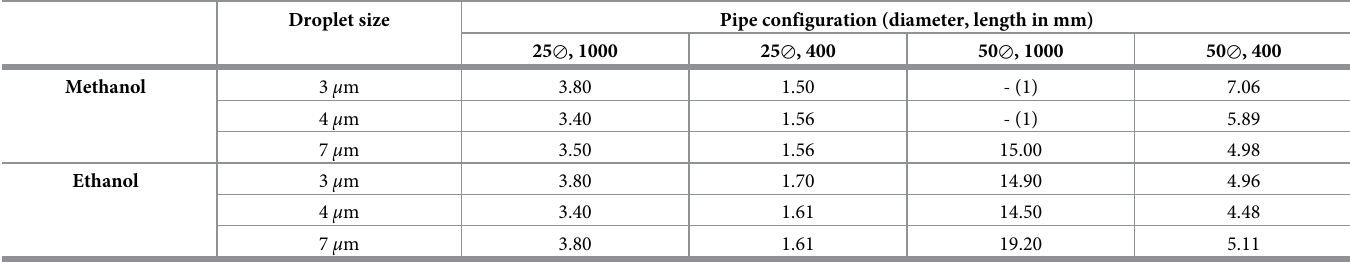
Table 3. t full in seconds as a function of droplet size and pipe type. Droplet size